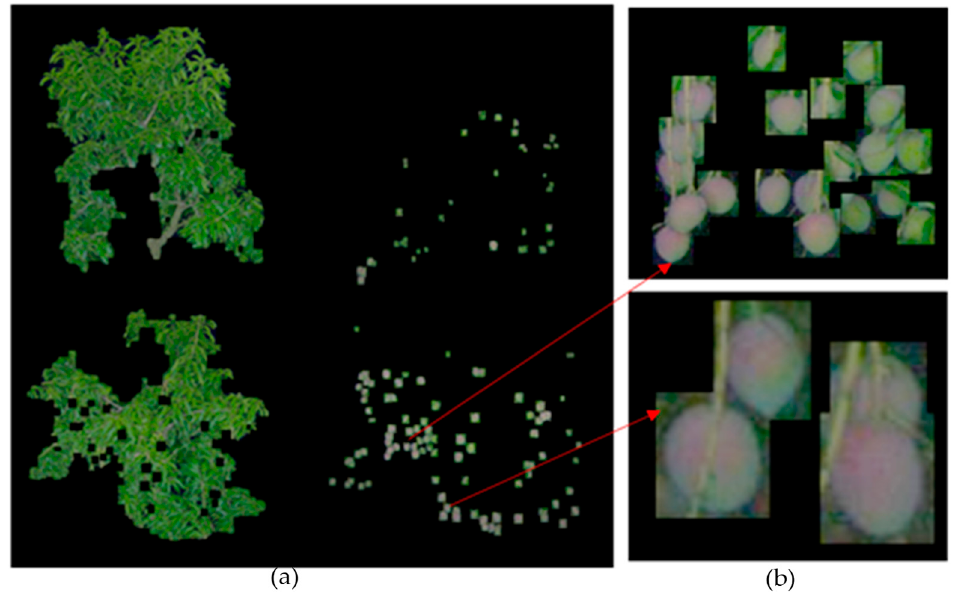
Figure 6. ( a )—a single image reconstructed from images of two sides of a canopy, with fruits and canopy separated. ( b )—closeup view of fruit images.